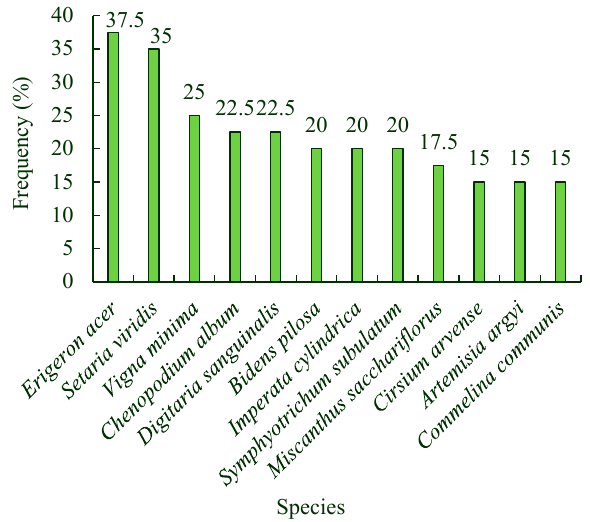
Figure 2. Distribution frequency of the 12 most widely distributed species of spontaneous plants in the Tangdao Bay National Wetland Park.